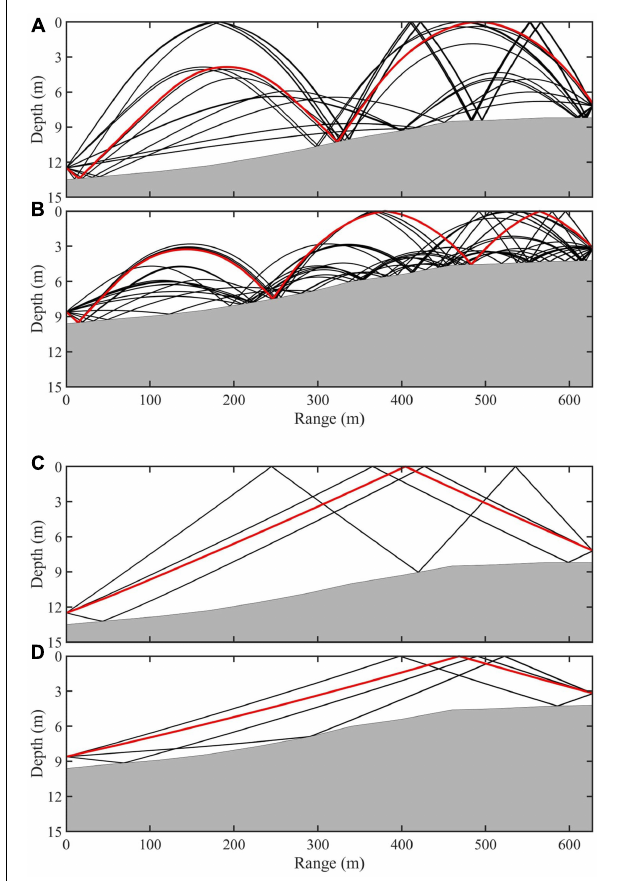
FIGURE 4 | Eigenrays for the (A,C) highest and (B,D) lowest tides in (A,B) August and (C,D) November. The red and black curves indicate the first acoustic ray and those that subsequently arrived, respectively.